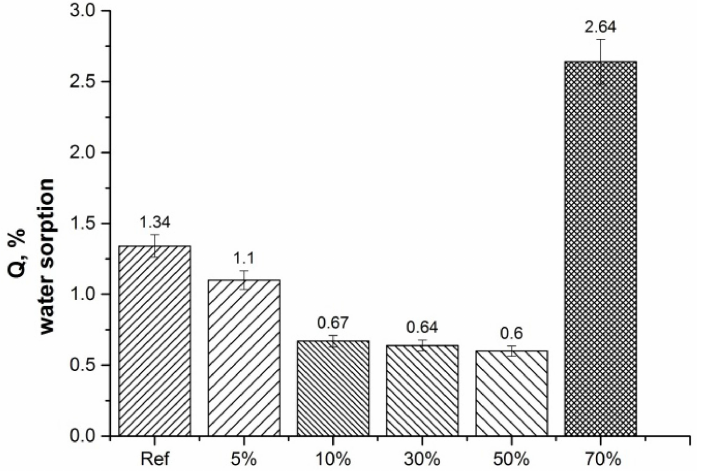
Figure 4. Sorption capacity (Q) of PLA films with variable OTOA